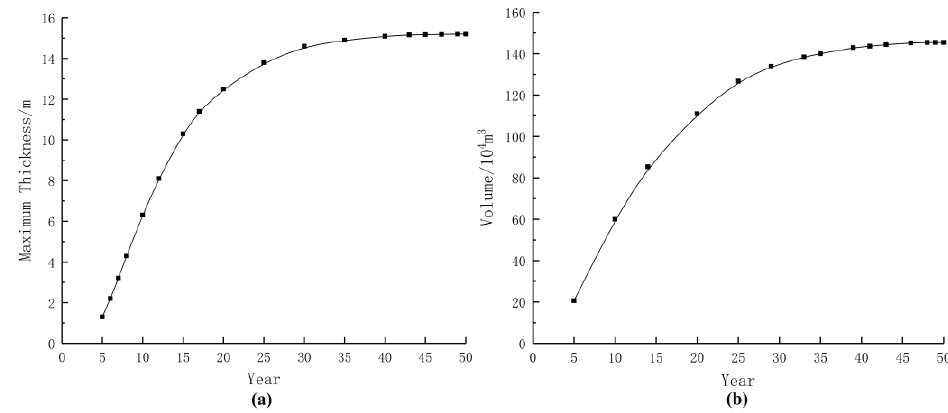
Figure 4. ( a ) Variation curve of max. thickness of freshwater lens; ( b ) variation curve of volume of freshwater lens.